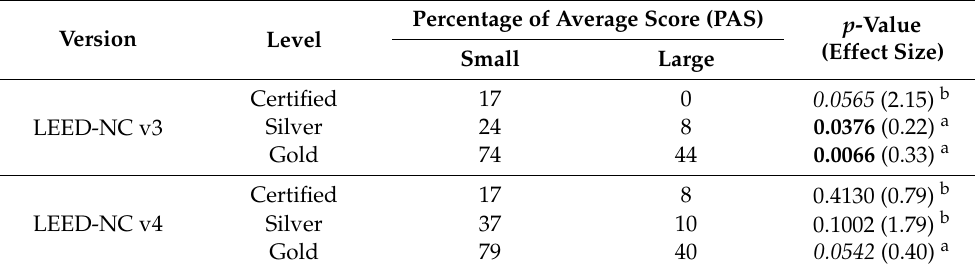
Table 10. LEED-NC v3/v4 office-type projects, renewable energy